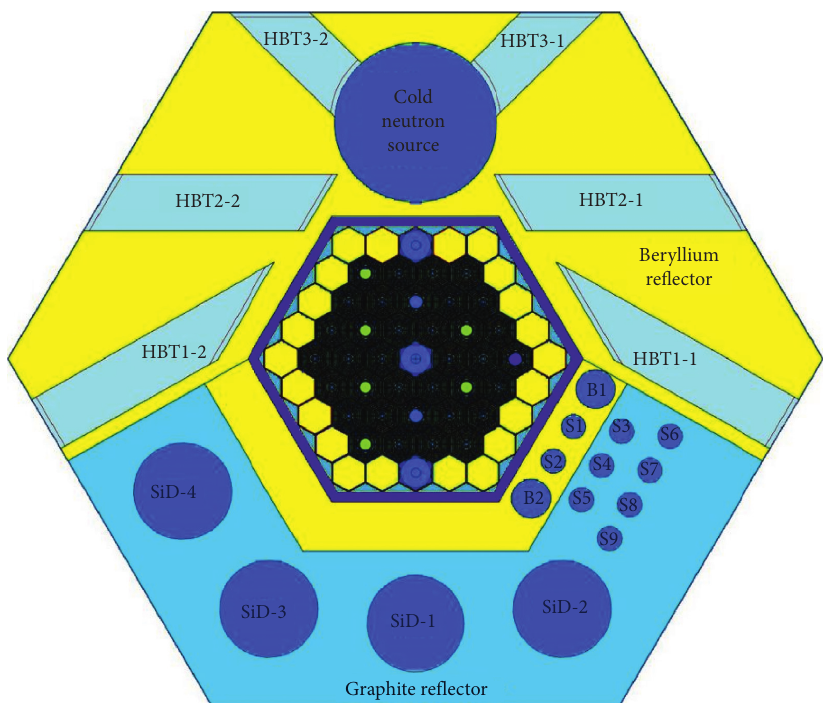
Figure 2: Horizontal cross-sectional view of the MPRR core. HBT: horizontal beam tubes; SiD-1 to SiD4: neutron transmutation doping of silicon; S1-S9: small irradiation channels; B1-B2: big irradiation channels.